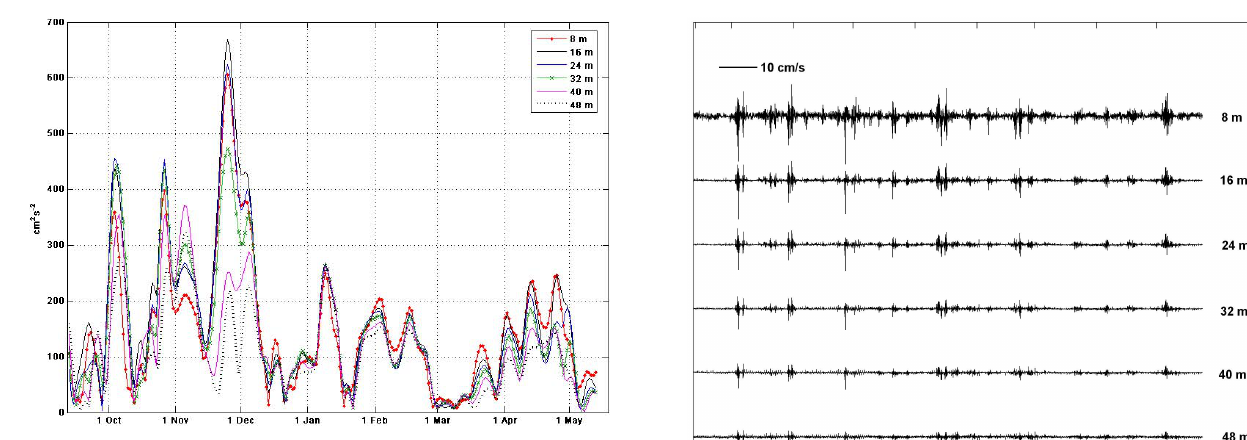
Fig. 13. Smoothed time series of energy on the inertial band (5.64– 6.03 10 − 2 cph) extracted from the spectrogram at each level.